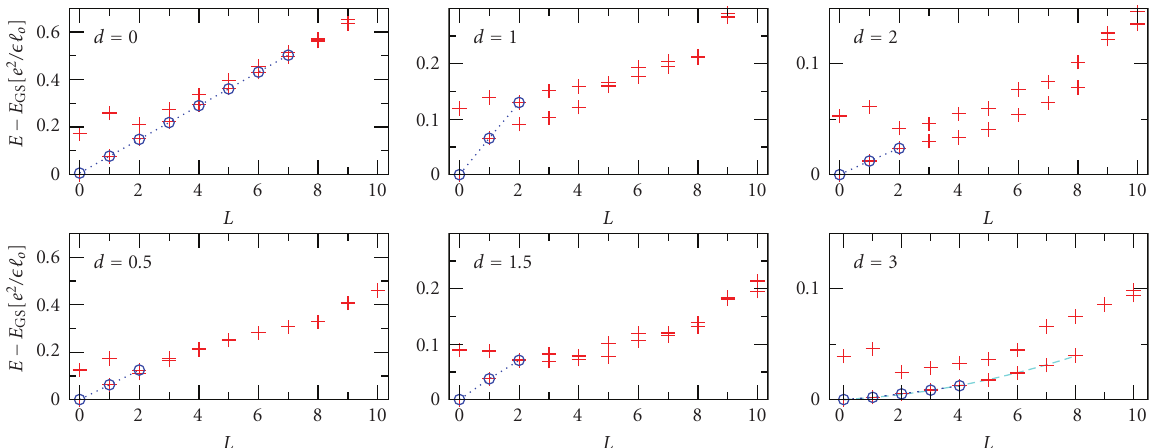
Figure 3: Spectra of the Coulomb Hamiltonian in the bilayer system on the sphere for N = 16 particles with N φ = 15 flux, for layer separations d ranging from d = 0 (top left) to d = 3 (cid:3) 0 (bottom right). Energies are indicated in units of e 2 / (cid:2) (cid:3) 0 relative to the ground state energy E GS at L = 0. Red crosses mark the lowest two eigenstates in each sector of given L . Blue circles indicate those states which were identified as part of the Goldstone branch by high overlaps (see Figure 1). At d = 0, the Goldstone mode is very well formed, while it is clearly visible at small and intermediate d how there are level crossings with additional low lying excitations. At d = 3, a mode of low-lying excitations is once again clearly separated from the rest of the spectrum, which terminates sharply at L = 8. Its dispersion is linear at small L , but it has a quadratic component responsible of the upturn at larger L . Note the change in the scale of the y -axis for the three columns of panels.